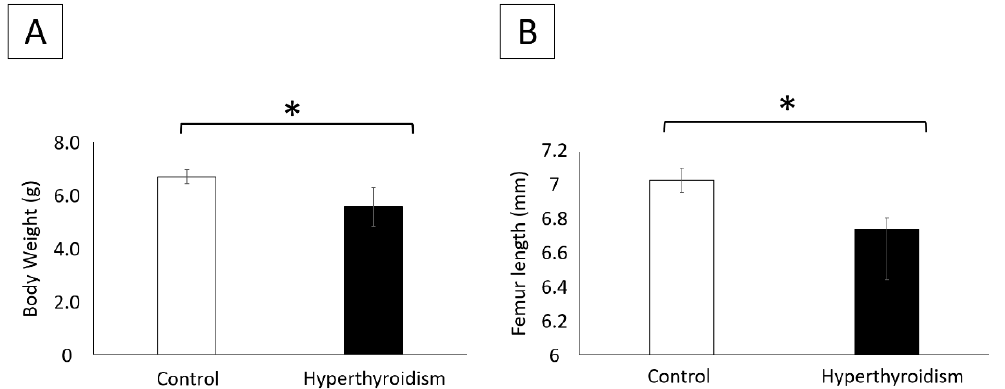
Figure 2. ( A ) Body weight (g) (mean ± standard deviation) of control neonates and those exposed to maternal hyperthyroidism. ( B ) Femur length (mm) (mean ± standard deviation) of control neonates and those exposed to maternal hyperthyroidism * p < 0.05.